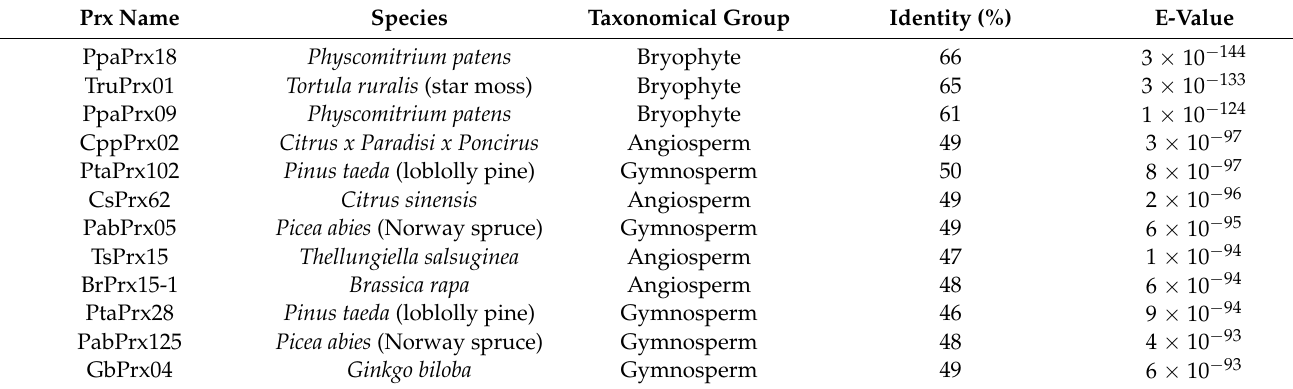
Table 2. Comparison of PpaPrx19 mature protein sequence with other class III peroxidases. The most similar peroxidase sequences based on BLASTP searches against the RedoxiBase database were used.